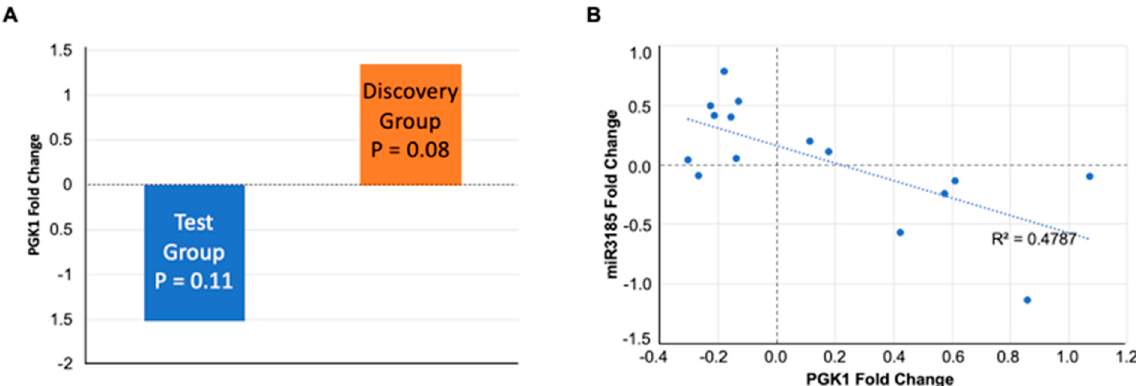
Figure 5. PGK1 levels in Test and Discovery groups, and correlation of PGK1 to mi3185. ( A ) The PGK1 fold change for the Test and Discovery groups is shown. ( B ) The relative PGK1 ( x -axis) and miR3185 levels ( y -axis) display an inverse relationship. The correlation coefficient is R 2 = 0.48 r (15) = 0.69, p = 0.0044).